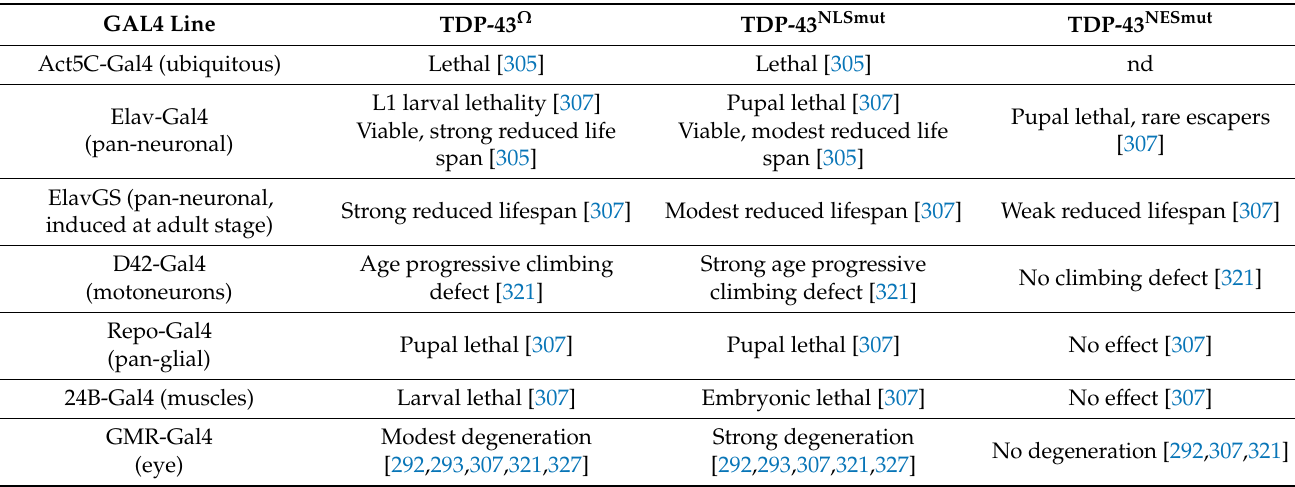
Table 12. Comparison of phenotypes induced by gain of function of TDP-43 wildtype, mutated in the NLS or in the NES. GAL4